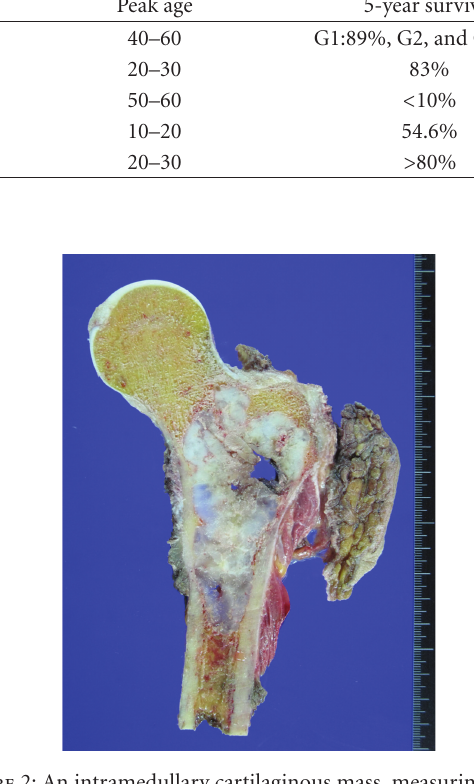
Figure 1: A well-demarcated cartilaginous tumor, measuring 6.5cm in greatest dimension, in the metaphysis of distal femur. The mass extends through the periosteum to adjacent soft tissue.